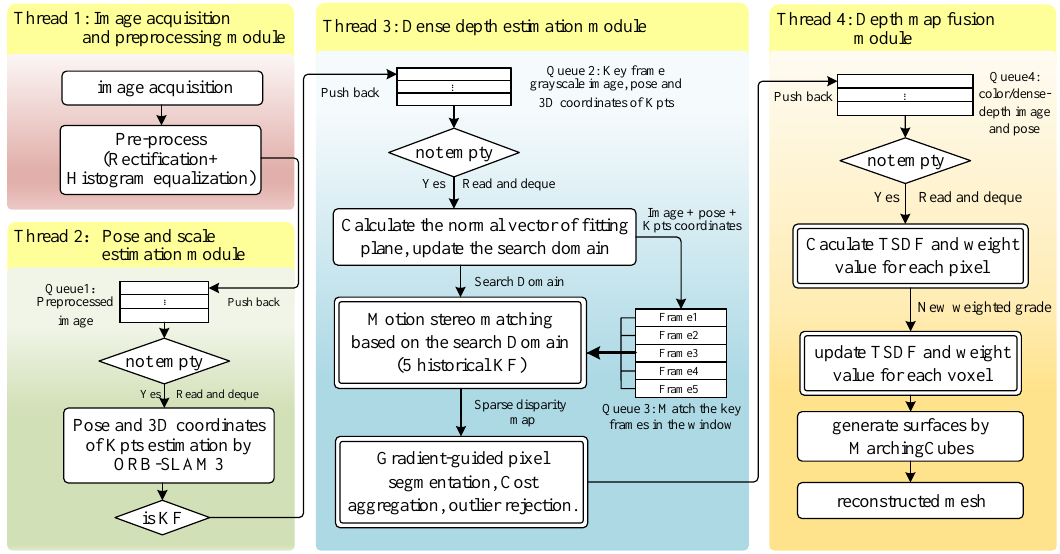
Figure 1. The framework of multi-processing